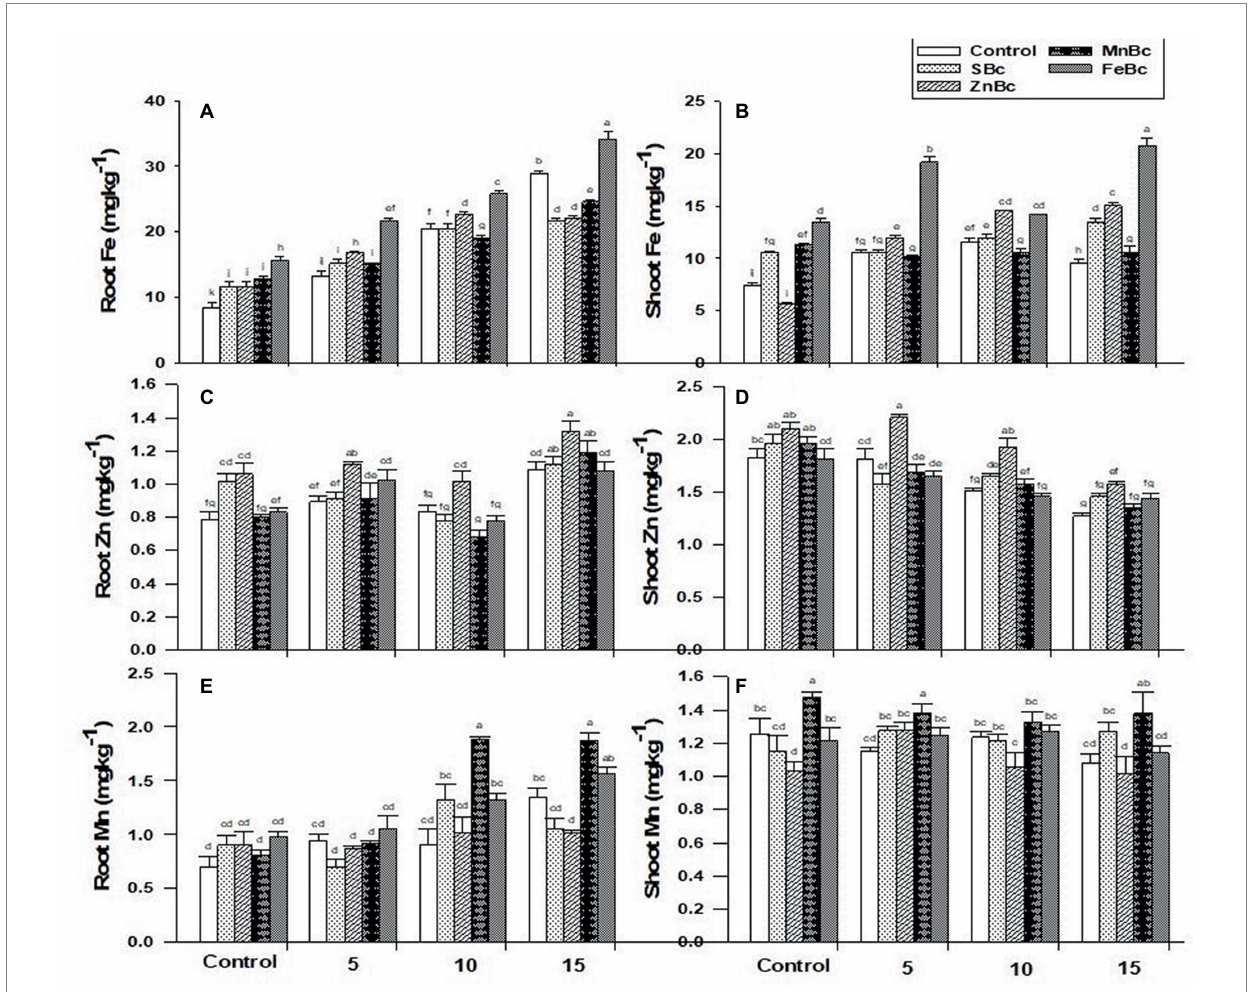
FIGURE 3 (A) Root Fe (mgkg − 1 ), (B) Shoot Fe (mgkg − 1 ), (C) Root Zn (mgkg − 1 ), (D) Shoot Zn (mgkg − 1 ), (E) Root Mn (mgkg − 1 ), and (F) Shoot Mn (mgkg − 1 ) of T. aestivum L. grown under various treatments such as T1 = DW, T2 = DW + 0.1% SBc, T3 = DW + 0.1% ZnBc, T4 = DW + 0.1% MnBc, T5 = DW + 0.1% FeBc, T6 = 5dSm − 1